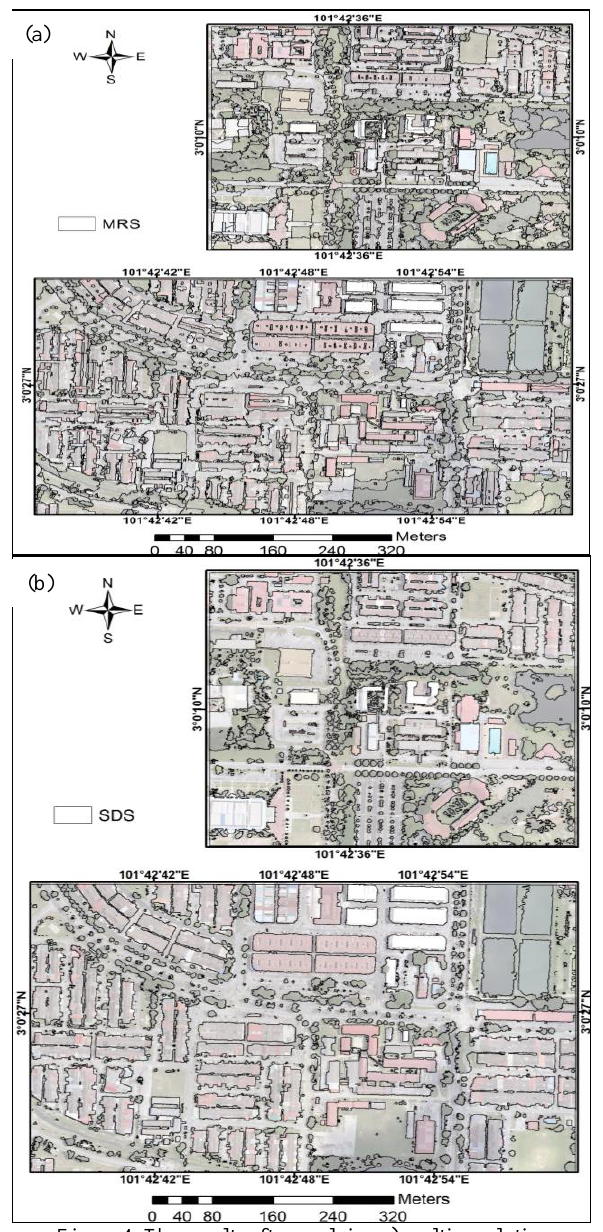
Figure 4. The results after applying a) multi-resolution segmentation, b) spectral difference segmentation.